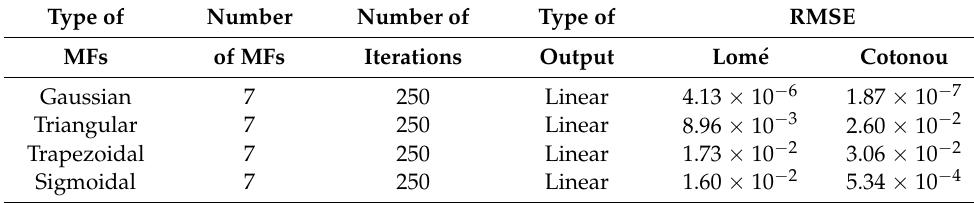
Table 6. Comparison of membership functions (MF) by their RMSE for Lom é and Cotonou.